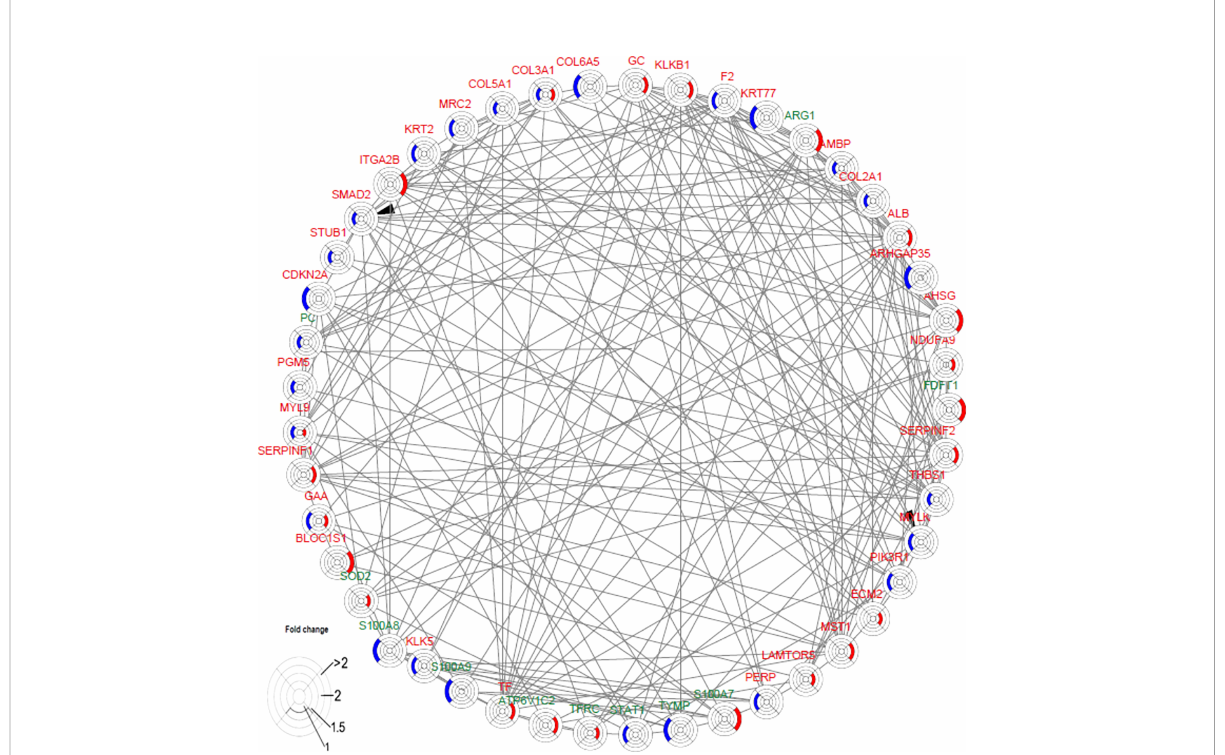
FIGURE 6 Causal network analysis obtained from ingenuity pathway analysis. Each protein is depicted with a radar chart that is made up of four rings; from the inside to out, it represents |log 2 FC|<=1, |log 2 FC|<=1.5, |log 2 FC|<=2, and |log 2 FC|>2. Red area represents the adalimumab group, and blue area represents the secukinumab group. The relation between two proteins is shown in lines (the arrow indicates predictive activation). Green colour for protein names indicates downregulation, and red colour indicates upregulation. Then, we applied Cytoscape (Version 3.9.1) to visualize the networks. The cut-off was set at p value<0.05 and |log 2(FC)| >log 2